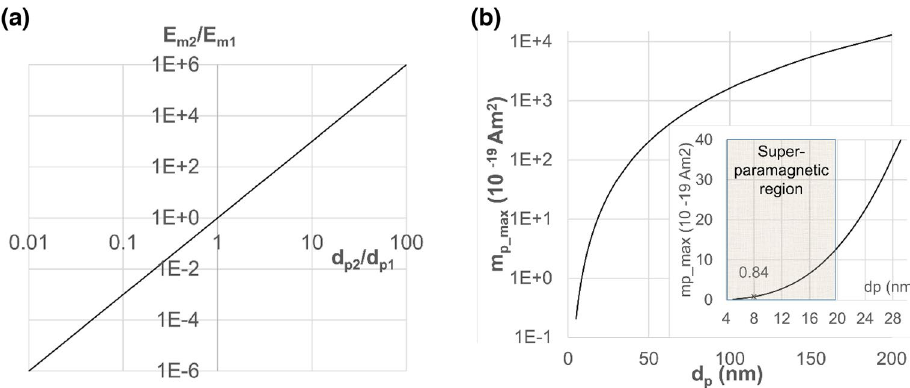
Figure 7. ( a ) Ratio of magnetic energy E m for two similar MNPs having magnetic diameters d p1 and d p2 in the same magnetic field. ( b ) Maximal magnetic moment of the particle m p _max versus its magnetic diameter d p